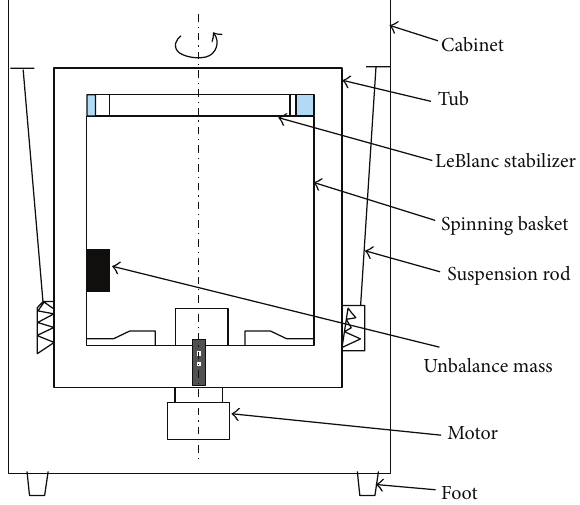
Figure 1: Schematic of a vertical axis washing machine and their main components.